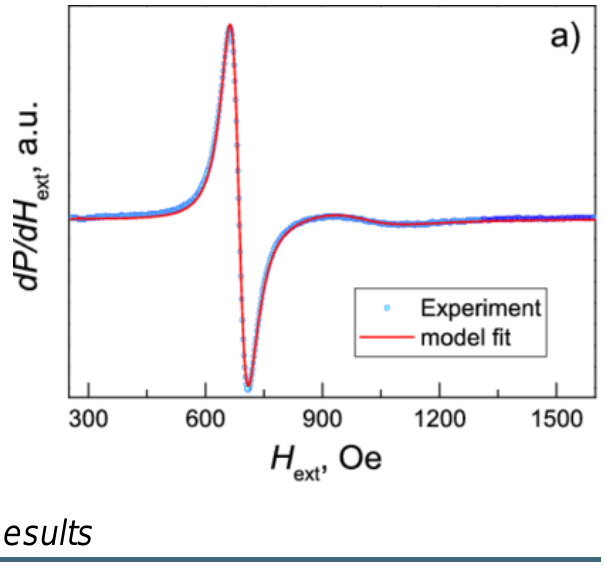
Figure 6. Establishment of the model based on the BP neural